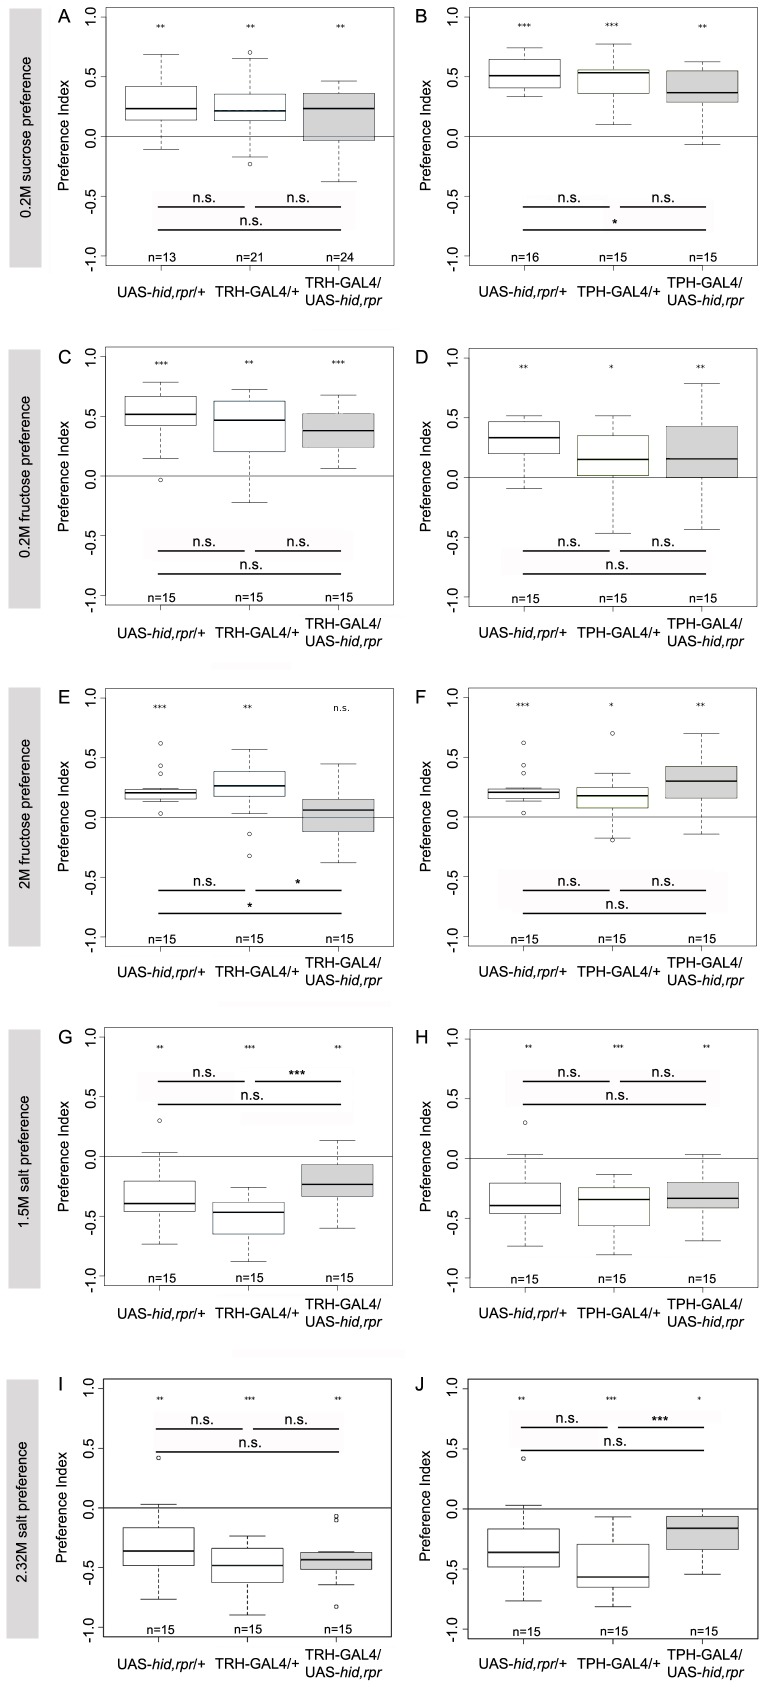
The Role of the Serotonergic System of the CNS for Gustatory Choice Behavior.Larvae were tested for their gustatory preference to different sugars (A–F) or salt (G–J) at varying concentrations. TRH-GAL4/UAS-hid,rpr larvae showed a strong preference for 0.2M sucrose (p<0.01) (A) and for 0.2M fructose (p<0.001) (C) with no significant difference to any control. Interestingly, TRH-GAL4/UAS-hid-rpr larvae did not prefer 2M fructose, whereas all controls did (p<0.05). In comparison with the control lines, no significant difference was found, except for 0.2M sucrose, where experimental larvae showed a slightly decreased preference compared to UAS-hid,rpr/+ (p<0.05) (B). TPH-GAL4/UAS-hid,rpr animals strongly preferred (p<0.01) 0.2M sucrose (B), 0.2M fructose (D) and 2M fructose (F). (E). Concerning 1.5M and 2.32M sodium chloride, we noticed a strong avoidance for both TRH-GAL4/UAS-hid,rpr ((G) p<0.01, (I) p<0.01) and TPH-GAL4/UAS-hid,rpr ((H) p<0.01, (J) p<0.05) experimental groups. The performance indices of TRH-GAL4/UAS-hid,rpr at 1.5M salt (G) and of TPH-GAL4-UAS-hid,rpr at 2.32M salt (J) were slightly reduced compared to the corresponding GAL4 control lines. Under each boxplot of the figure for each genotype the sample size is shown; n = 13−24. Asterisks above each boxplot indicate, if the data is significantly different from zero. n.s.>0.05; *<0.05; **<0.01; ***<0.001.